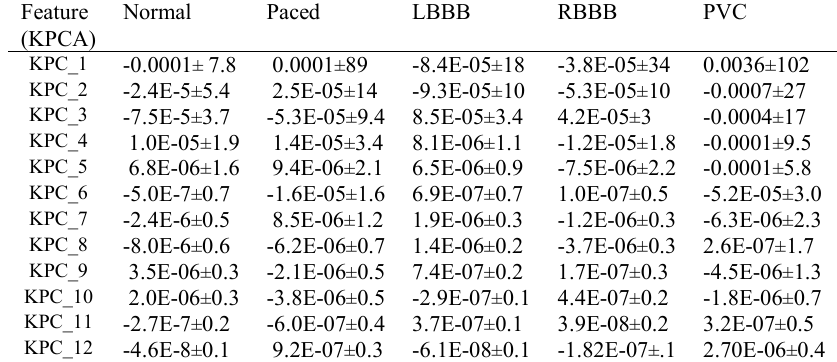
Table 2. Twelve kernel principal coefficients extracted from 130 data points of samples of a single beat Normal Paced LBBB RBBB PVC Feature (KPCA) KPC_1 -0.0001 ± 7.8